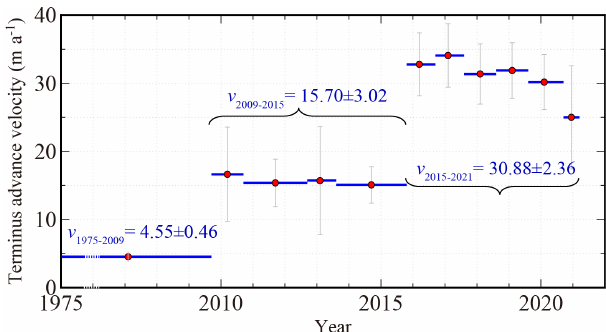
Figure 4. Terminus advance velocities and the associated uncer- tainties (the light gray error bars) of the KLP-37 glacier estimated from KH-9 and Planet images. We also annotated the mean veloci- ties during three periods: 1975–2009, 2009–2015, and 2015–2021. Note that the time axis during 1975–2009 is not equally posted for a better presentation.